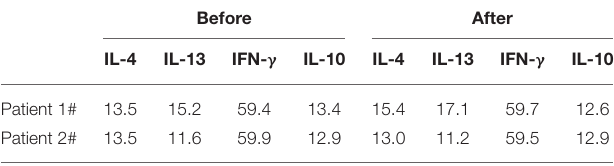
TABLE 2 | Sera cytokines levels before and after Dupilumab